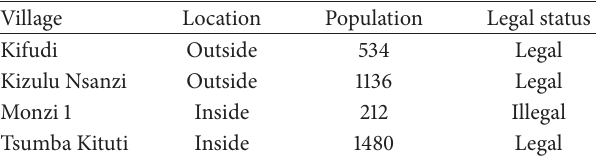
Table 1: Characteristics of the selected